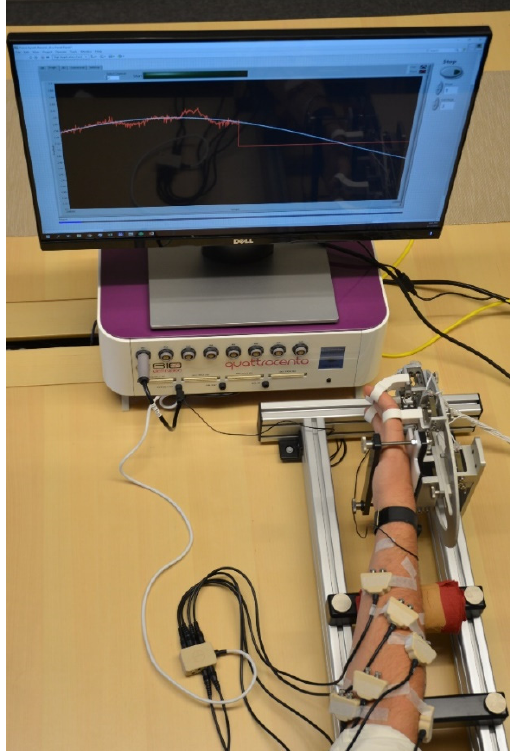
Figure 1. Measurement setup. The participants were following the slowly changing sine wave (repetition frequency was 0.1 Hz) with a finger DoF by producing isometric contractions. The forces were acquired by the force measurement device and displayed in real-time on the screen. Fine-wire electrodes were taped at the skin entry point to prevent accidental pulls. To reduce induced noise, the preamplifiers were placed as close as possible to the entry points of the fine wires. In addition, the wires between the entry point and preamplifiers were taped to the skin. The metal frame of the force measurement device was grounded to reduce powerline noise.